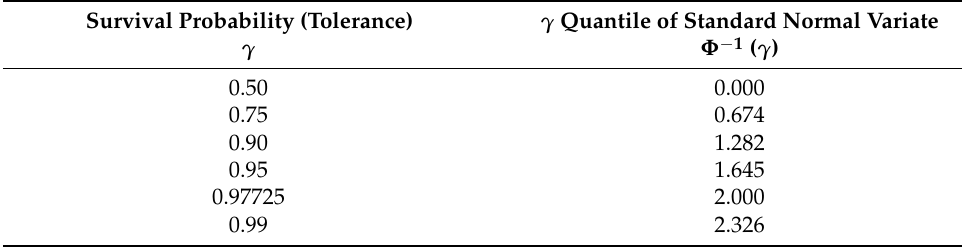
Table 3. The inverse standard Gaussian cumulative distribution